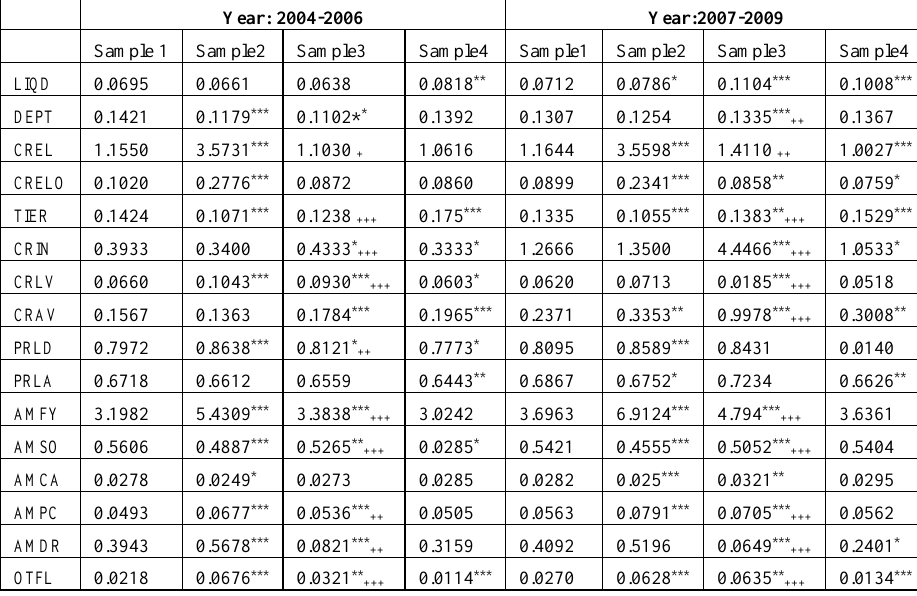
Fig. 3. Analysis of the impact of business characteristics of sample group 3 on liquidity and risk before and during the financial crisis. Table 3. Wilcoxon test of sample group variables from 2004 to